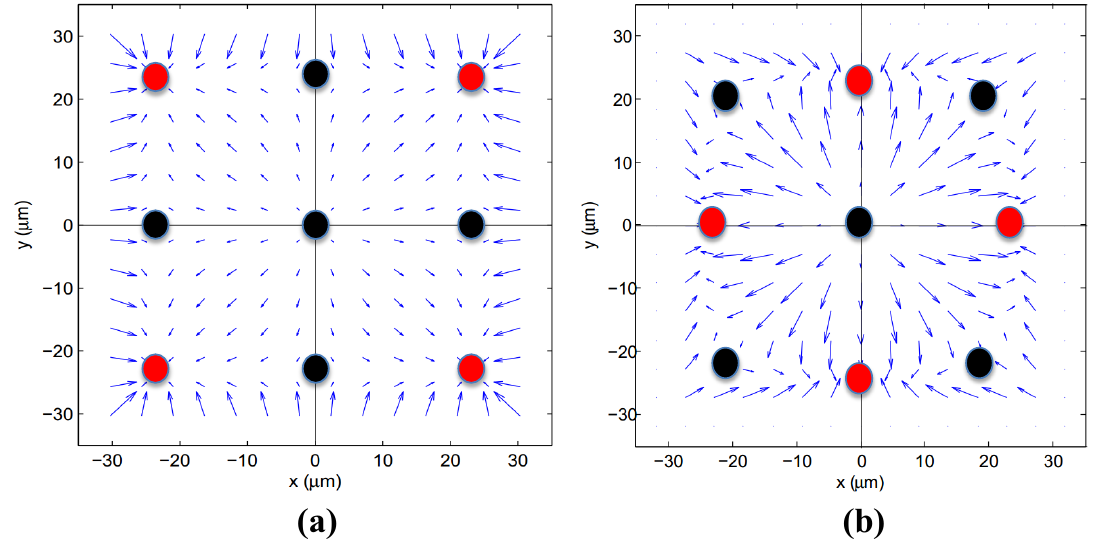
Figure 1. Inertial force field together with stable and unstable equilibrium points in a square channel: ( a ) Asmolov’s study; ( b ) Hood’s study [34] (red points: stable equilibrium; black points: unstable